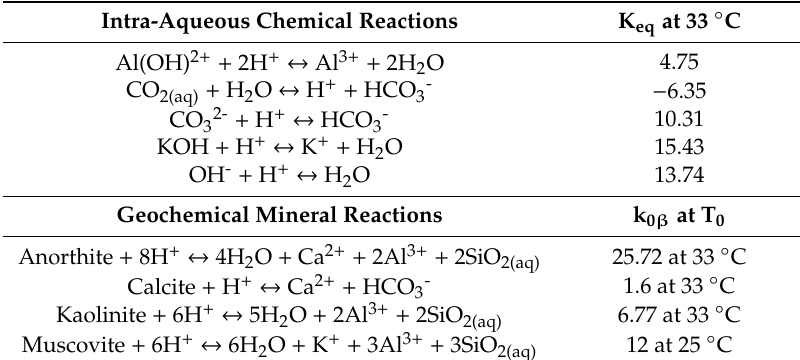
Table 2. Chemical reactions of the aqueous phase and mineral reactions used in this study. (The reaction rate constant was adopted from the Thibeau et al. (2007) [22]).